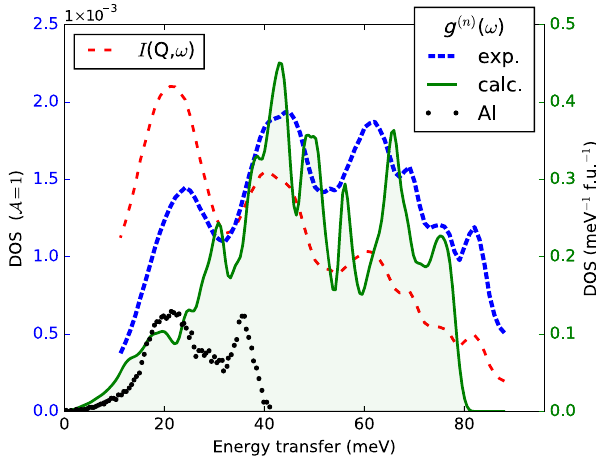
Þ Cr 0 2 O 3 extracted . 96 . 04